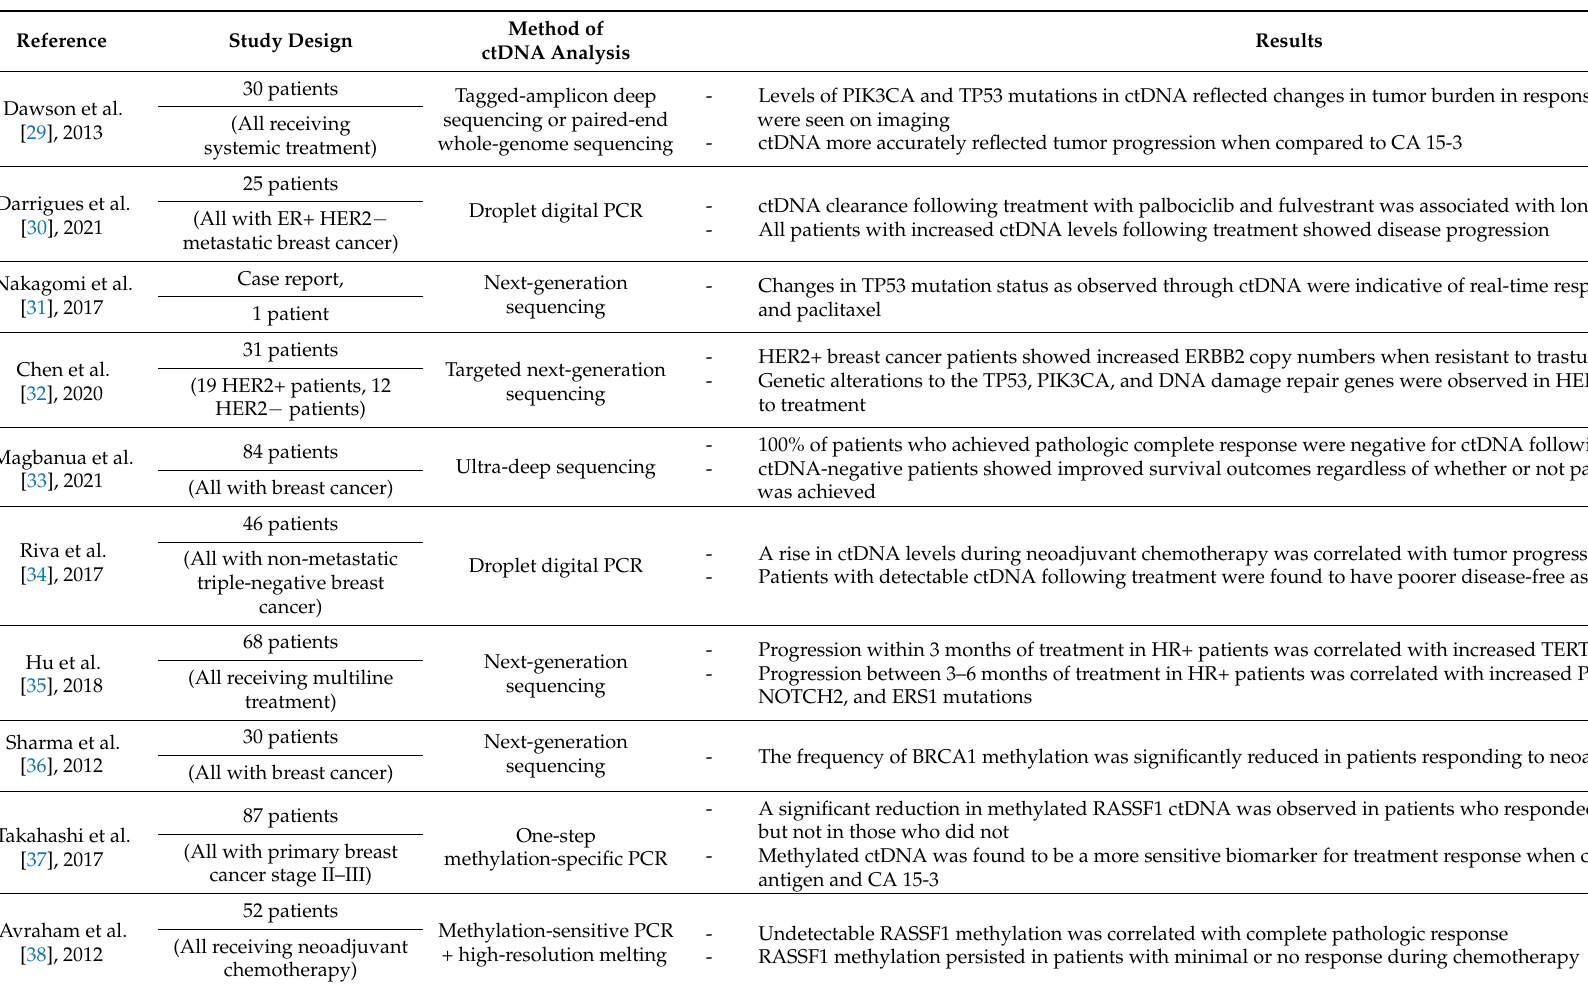
Table 2. Summary of studies exploring the use of ctDNA for the assessment of treatment response in breast cancer